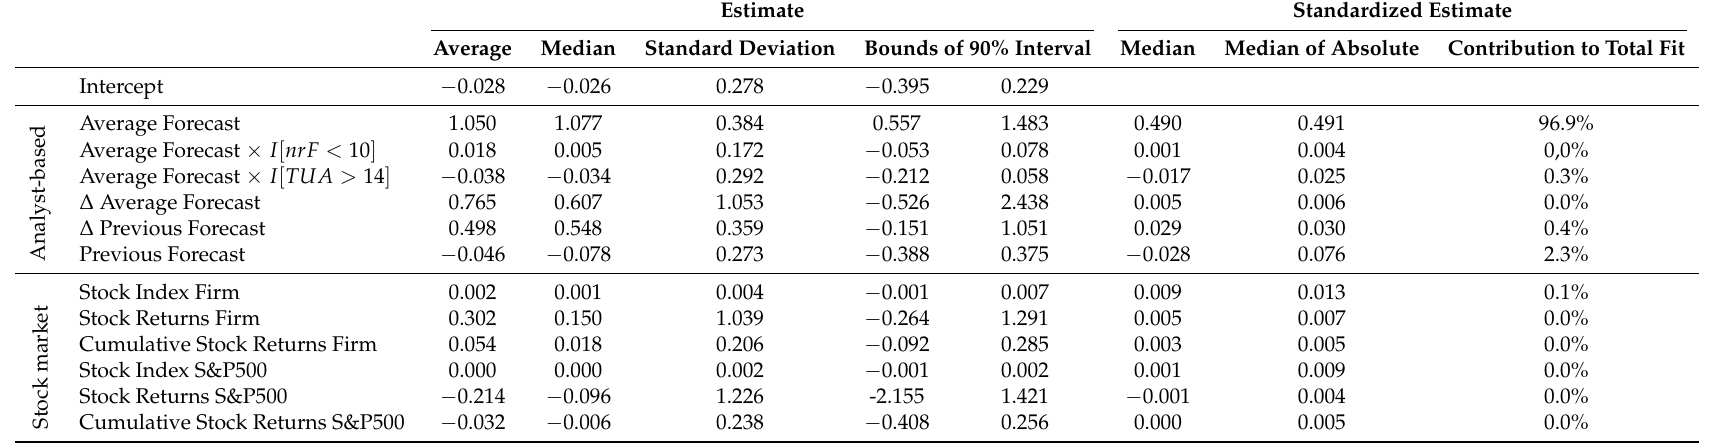
Table 3. A summary of estimation results of forecasting earnings forecasts. Results are for the estimation sample, which amounts to 316 firms, 18.338 forecasters and 146.319 forecasts (on average slightly more than 463 forecasts per firm). As variable to be explained, we used the earnings forecasts by the analysts. As explanatory variables, we included the variables mentioned in Table 2. The regression was run individually for each firm, and the table shows statistics which summarize these results. The first five columns contain summary results on the regular parameter estimates (average, median, standard deviation and bounds of a 90% interval). The last three columns show summarized results for the standardized estimate, which is included to compare contributions to fit. The standardized estimate is defined as the estimate that would have been obtained had the regressor been standardized beforehand (which is a transformation to having an average of zero and a standard deviation of